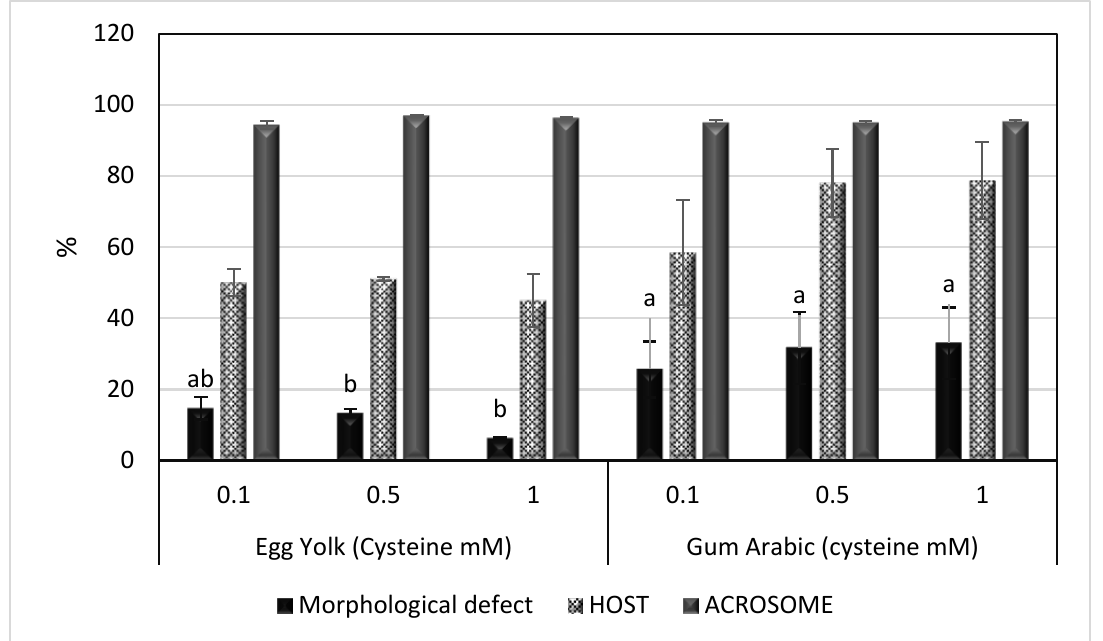
Figure 2. Mean ± SEM of morphological defects, HOST and acrosome integrity of spermatozoa in egg yolk or gum arabic extenders supplemented with different concentrations of cysteine (0.1, 0.5 and 1 mM) and stored by deep freezing at − 196 °C. HOST: hypoosmotic swelling test. a,b bars bearing different superscripts are significantly different ( p < 0.05). Table 2. Spermatozoa motility and viability parameters (mean ± SEM) in egg yolk and gum arabic extenders supplemented with different concentrations of cysteine (0.1, 0.5 and 1 mM) and stored by deep freezing at − 196 °C.